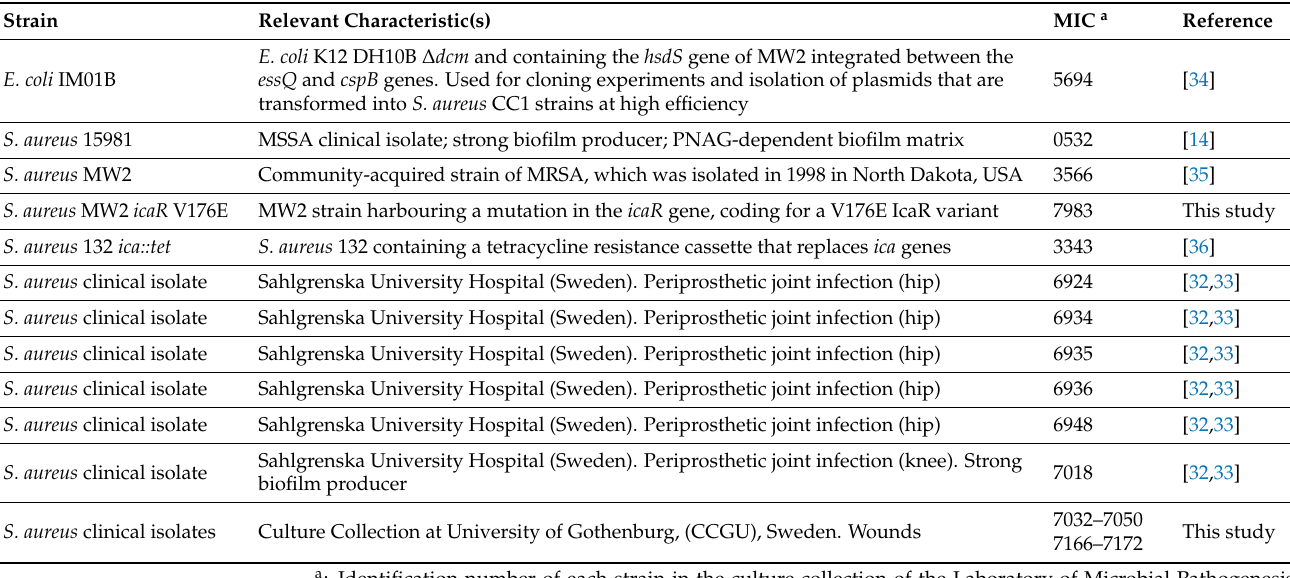
Table 1. Bacterial strains used in this study.